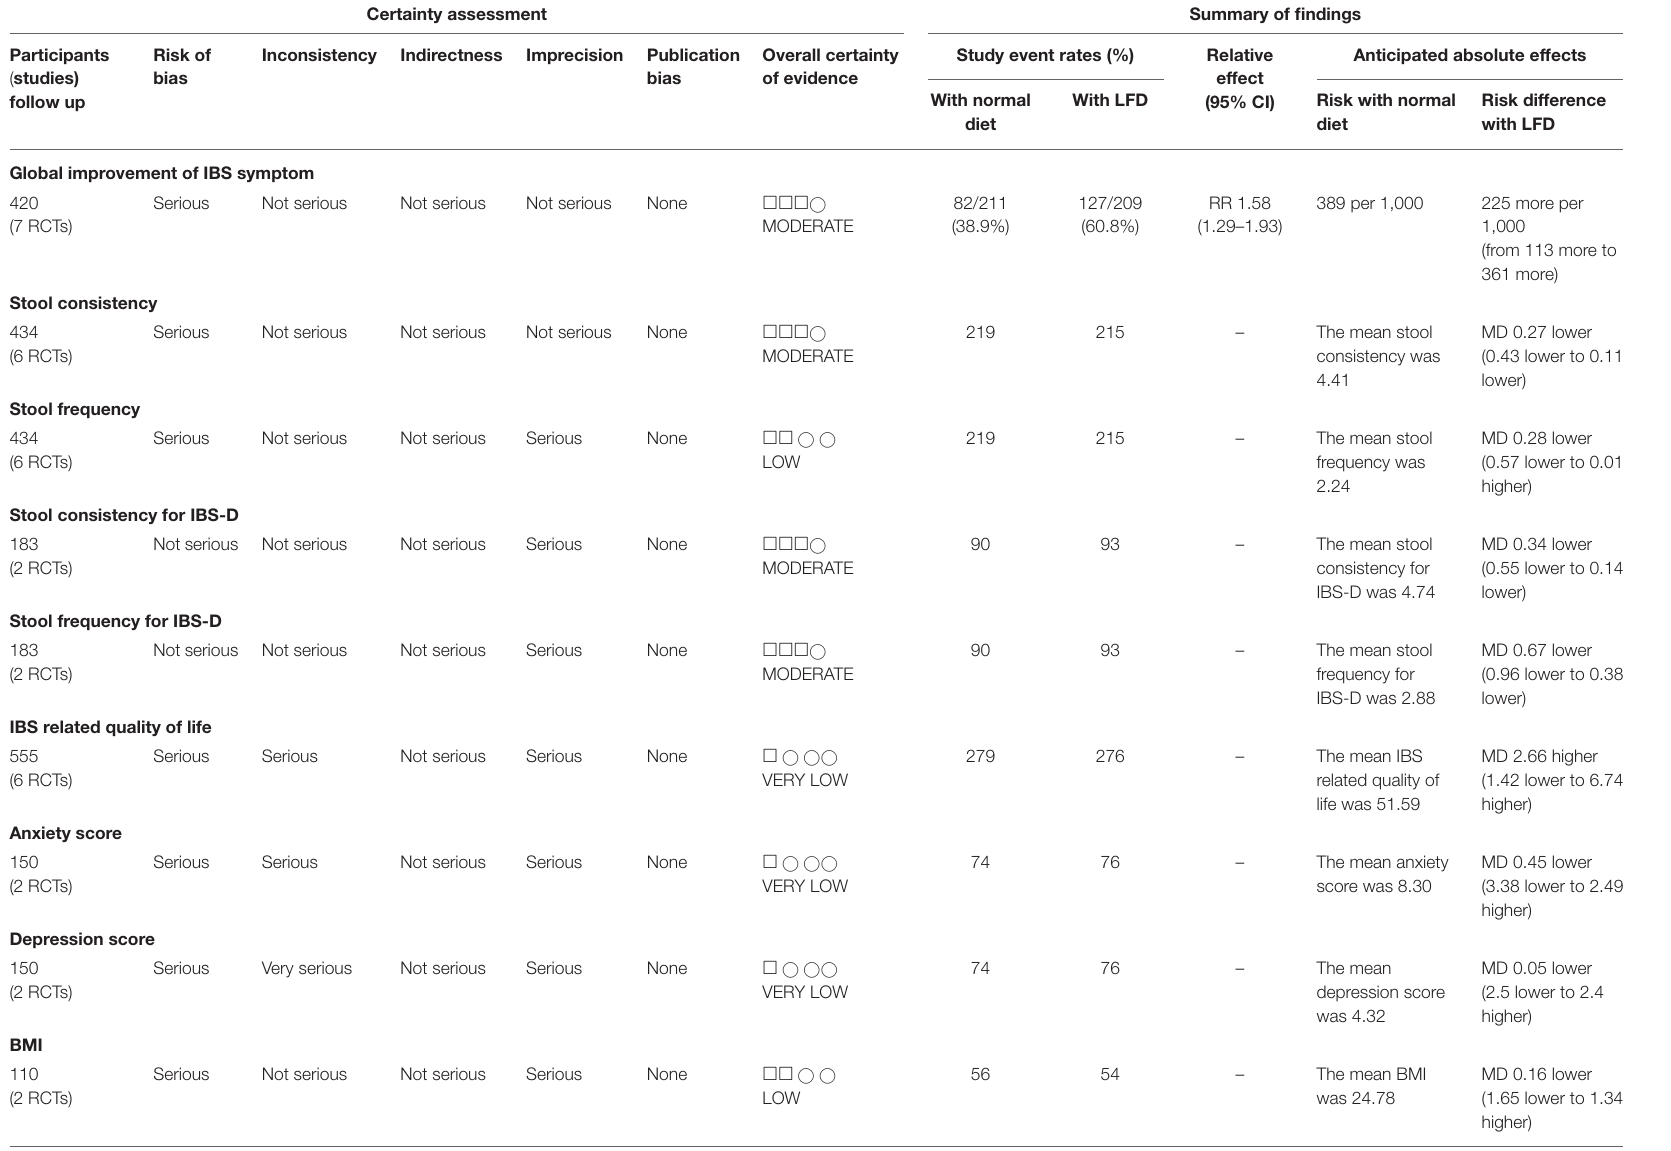
TABLE 2 | Grading of recommended assessment, development and evaluation (GRADE) summary of